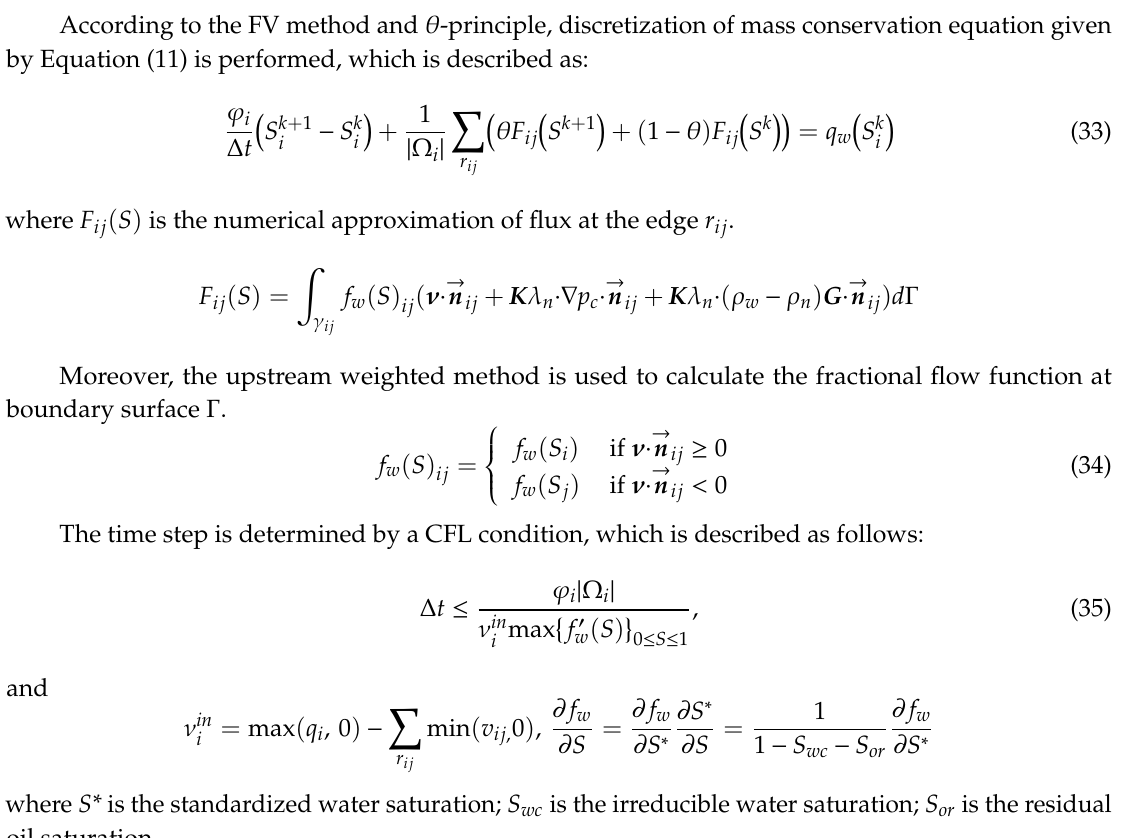
Figure 5. Delaunay triangulation of the water-injection model. Table 1. Rock and fluid properties for the staggered five spot water-injection model. Parameter